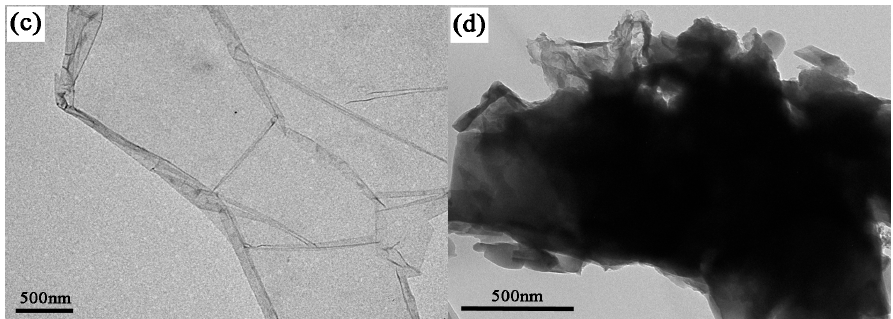
Figure 5. FE-SEM images of GO ( a ) and GO-CS-PHGC ( b ); TEM images of GO ( c ) and GO-CS-PHGC ( d ).